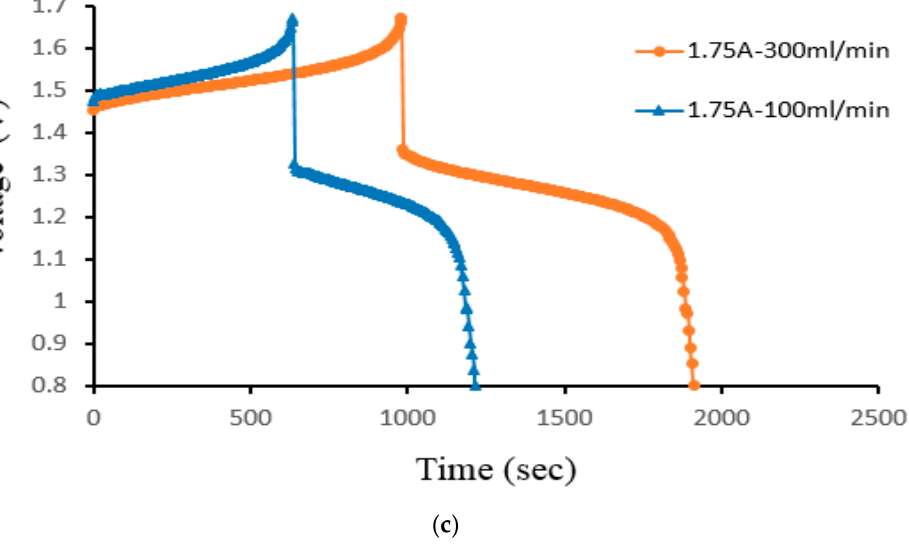
Figure 13. Cell voltage varied through time to reflect charge/discharge characteristics of Case 4 at the controlled flow rates (100 mL/min and 300 mL/min) for current density ( a ) 40 mA/cm 2 , ( b ) 60 mA/cm 2 , and ( c ) 70 mA/cm 2 from the experiment.